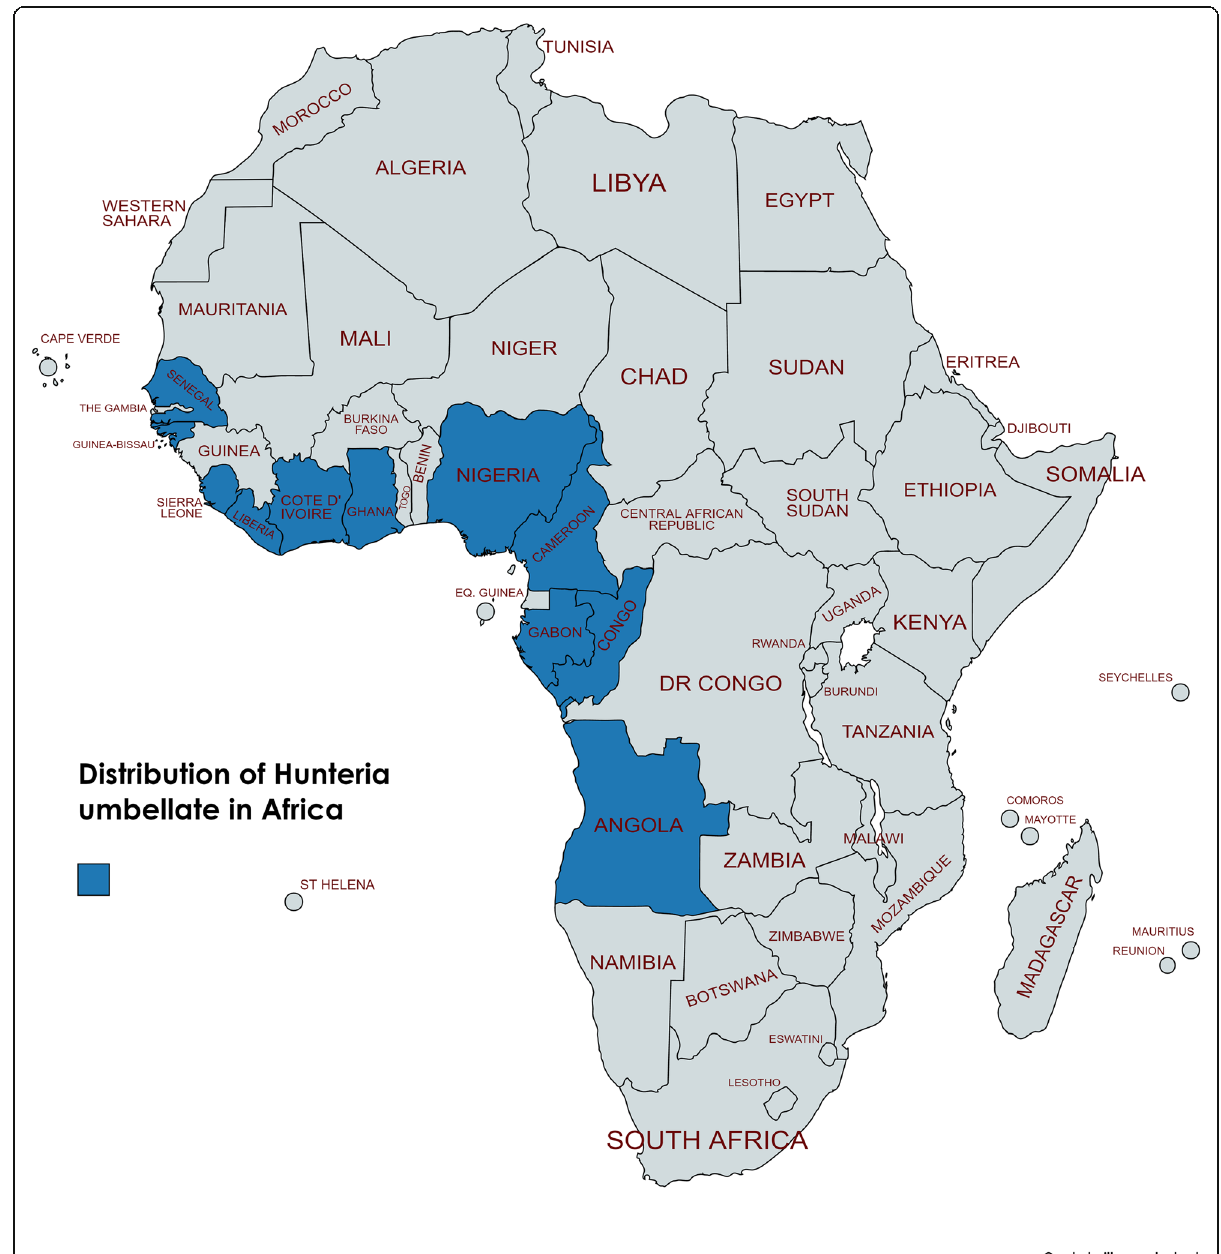
Fig. 1 Geographical distribution of H. umbellate in